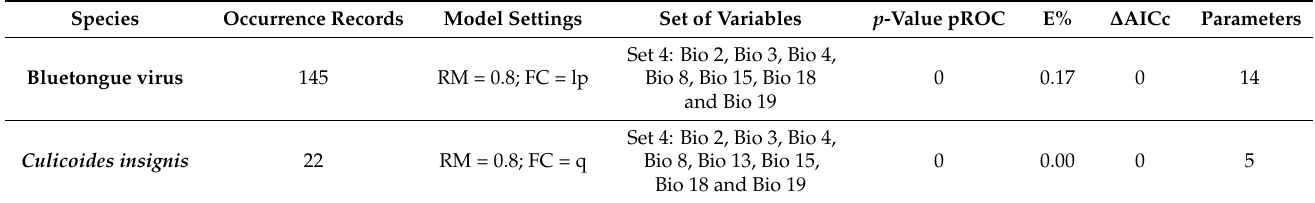
Table 1. Description of metrics of the selected models for each